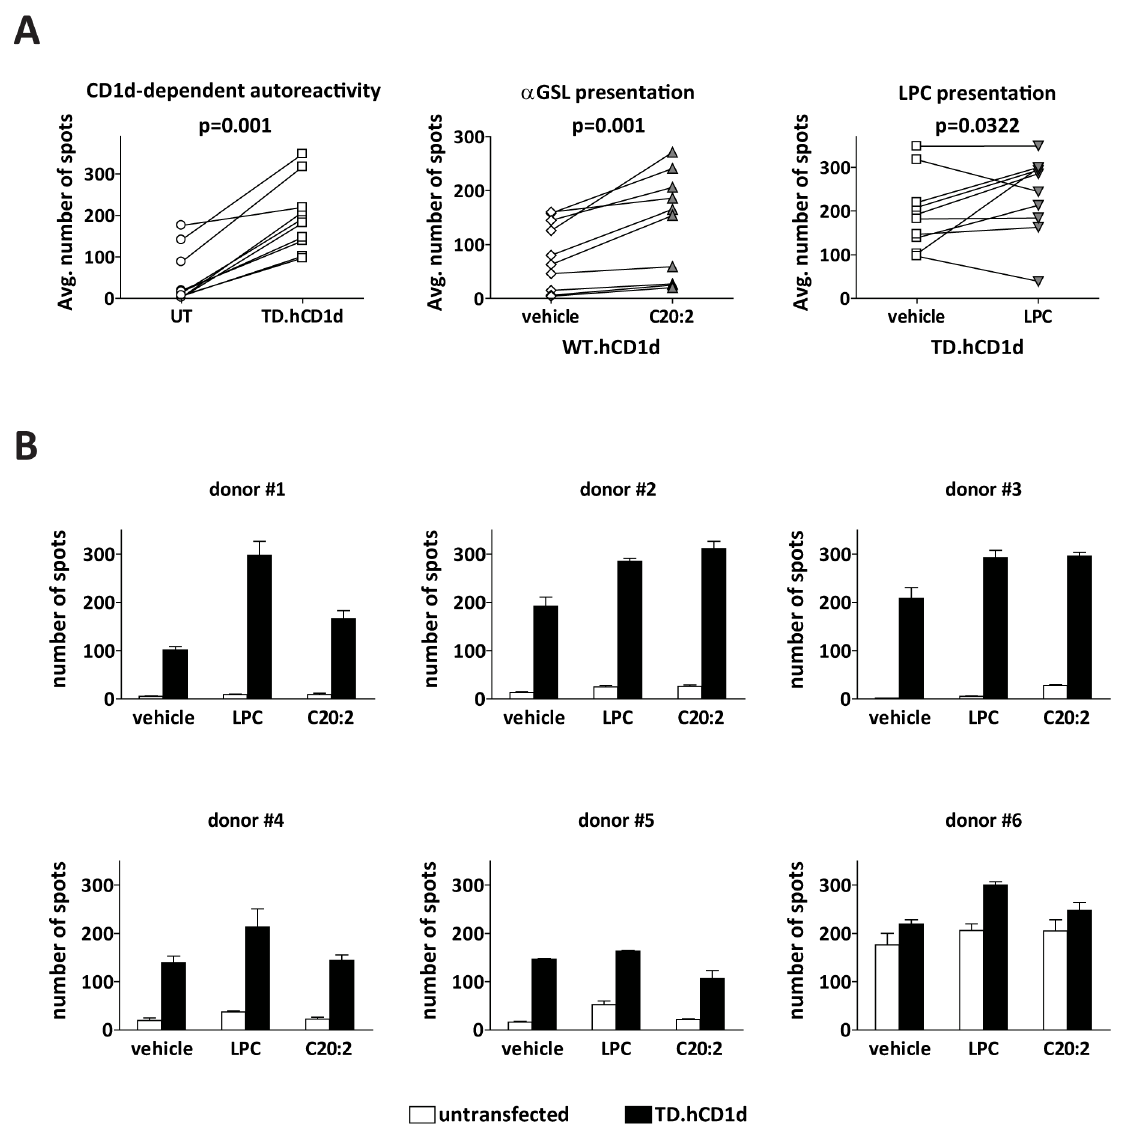
Figure 7. Activation of human peripheral blood lymphocytes. CD1d-transfected or untransfected APCs were pulsed with antigen or treated with vehicle alone, and then used to stimulate freshly isolated PBLs from ten healthy human donors. The frequency of IFN c -secreting cells in each sample was assessed by ELISpot analysis. (A) Comparison of the average number of positive spots from triplicate wells of PBLs stimulated with the following APCs: left plot, untransfected (UT) APCs versus CD1d tail-deleted transfectant (TD.hCD1d) treated with vehicle alone; middle plot, wild-type CD1d transfectant (WT.hCD1d) treated with either vehicle or C20:2 a -GSL; right plot, tail-deleted CD1d transfectant treated with either vehicle or LPC. The data were statistically analyzed using a one-tailed Wilcoxon signed-rank t -test, yielding the p -values shown on the plots. (B) Results from individual donor samples that showed statistically significant increases in IFN c spots in response to APCs treated with LPC. The plots show the mean numbers of spots detected from untransfected APCs (open bars) or tail-deleted CD1d transfectants (filled bars) that were prepulsed with the indicated lipid antigens or with vehicle alone. The p -values for responses to CD1d-transfected cells pulsed with LPC versus vehicle alone are as follows: donor # 1 p =0.0027; donor # 2 p =0.0096; donor # 3 p =0.0302; donor # 4 p =0.105; donor # 5 p =0.0021; and donor # 6 p